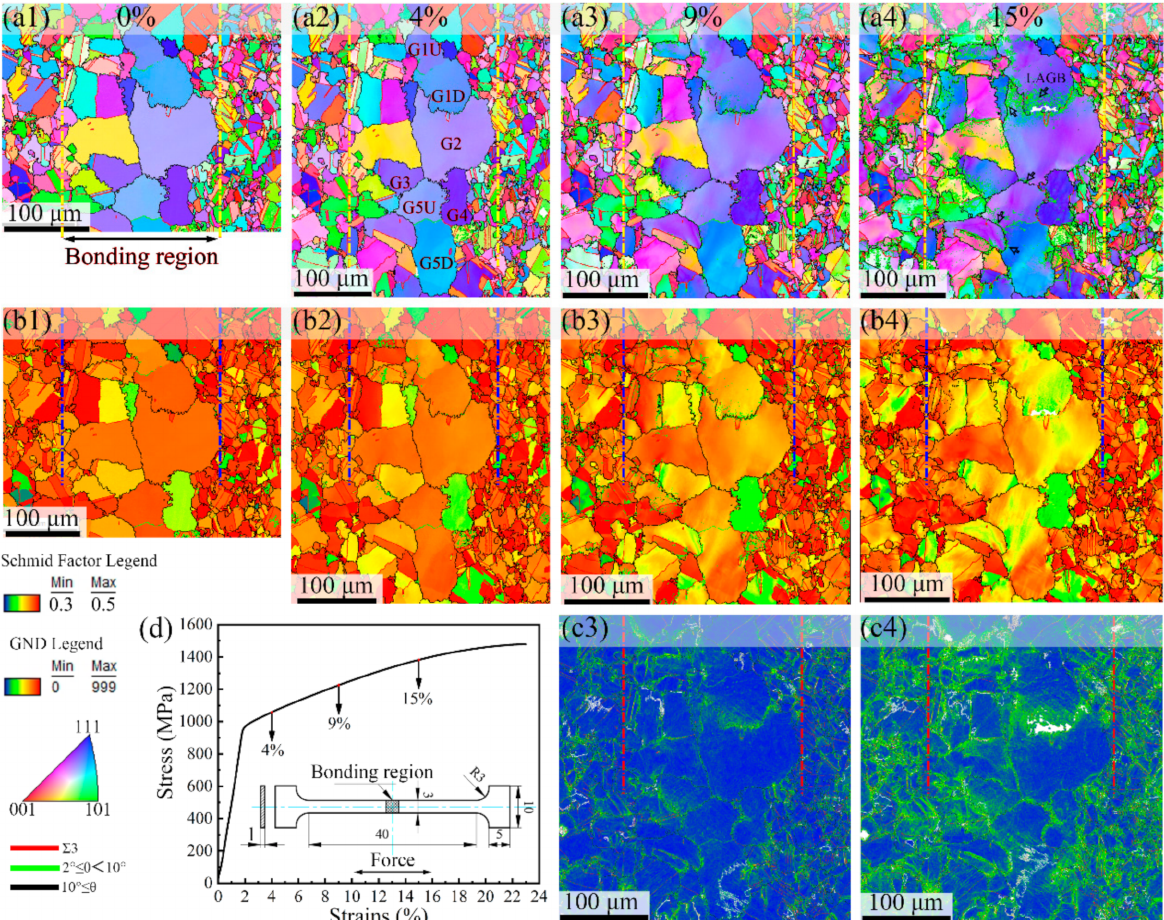
Figure 9. The EBSD patterns evolution of the original joint at different global strains. Orientation image microscopy maps (OIMs) with corresponding inverse polar figure (IPF)//X-axis (the stress direction) ( a1 – a4 ), Schmid Factor for {111}<11-2> slips systems ( b1 – b4 ), and GND ( c3 , c4 ), ( d ) the preset engineering strain values for quasi in situ EBSD observation, and the dimensions of the tensile specimen with the stress direction (the inserted